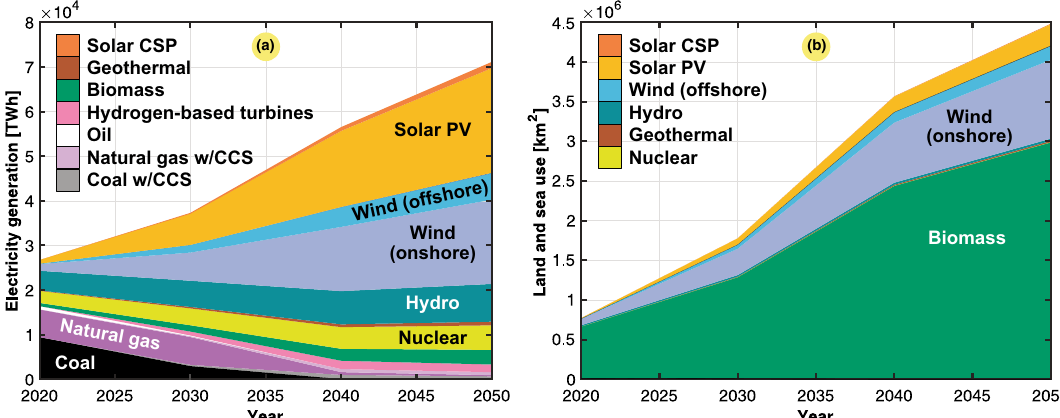
Figure 15. Filled area plots of the changes in the worldwide energy mix composition according to the IEA NZE scenario 22 . ( a ) Electricity generation mix (adopted from Table 19). ( b ) Predicted land and sea use requirements (adopted from Table